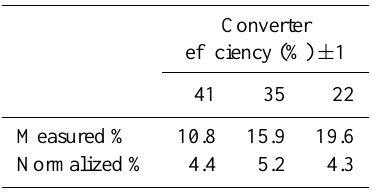
Table 4. The average percentage conversion of PAN to NO 2 mea- sured, and normalized to the converter efficiency of each BLC.